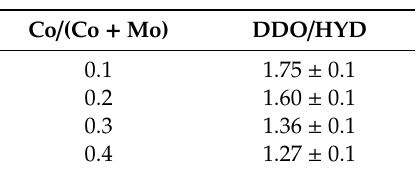
Table 3. Direct deoxygenation and hydrogenation route ratio of HDO of phenol at 20% of the phenol conversion for the CoMo/AT2 catalyst.